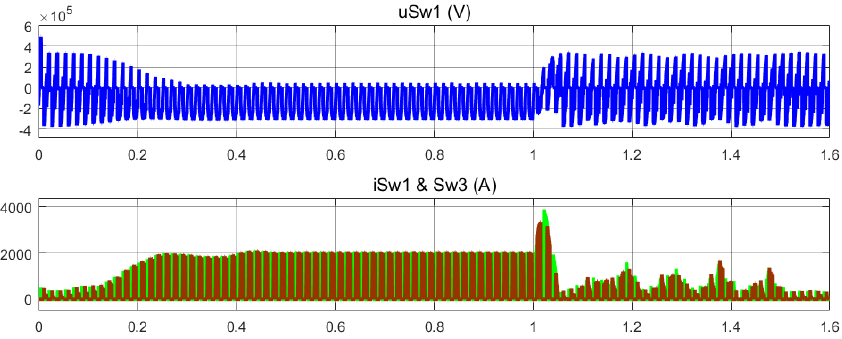
Figure 12. The reliable state condition at the rectifier section without any abnormal DC